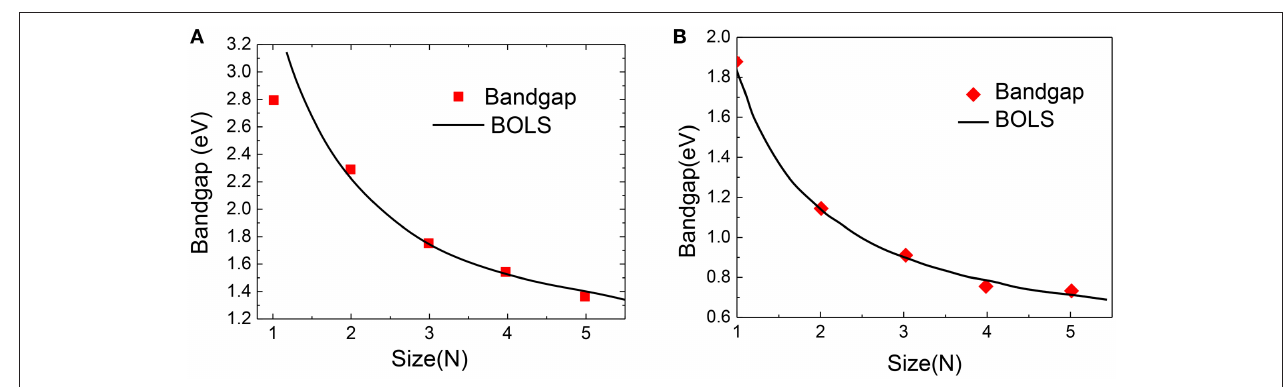
FIGURE 11 | BOLS reproduction of the DFT calculated size-dependency of (A) zigzag PNRs and (B) armchair PNRs. Reprint with permission from Liu et al. [98].